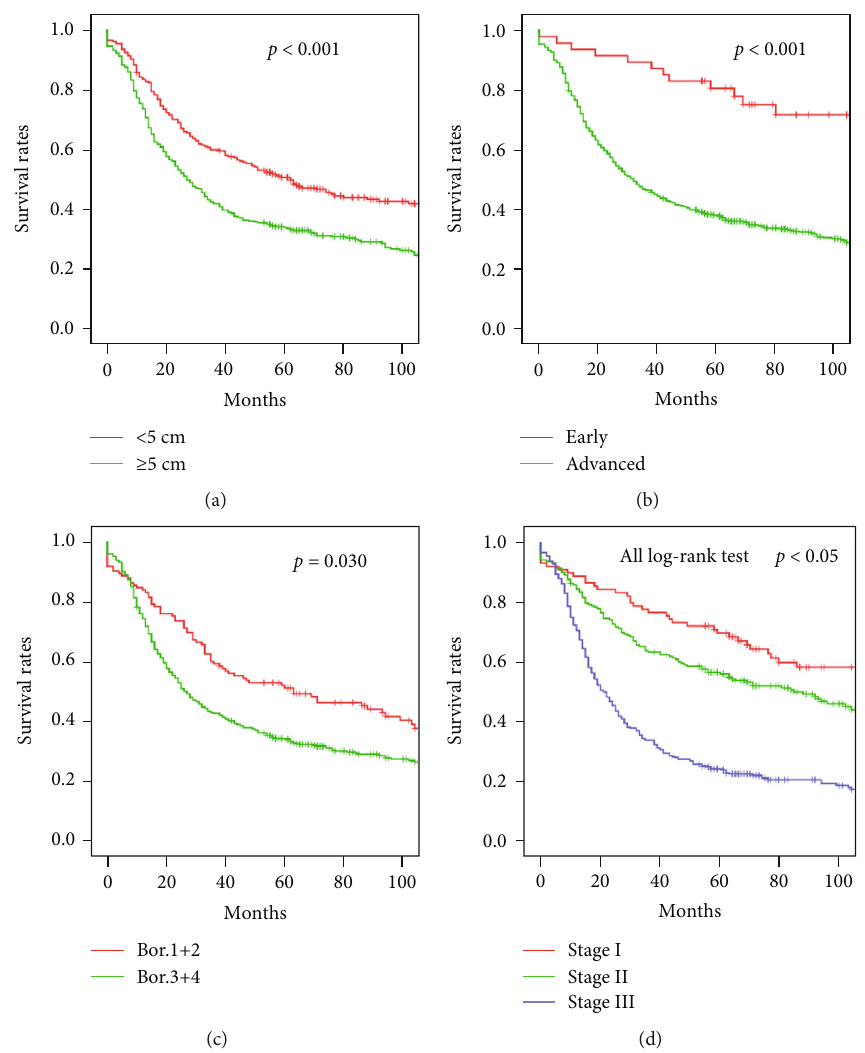
Figure 2: Survival of patients with upper gastric cancer: (a) tumor diameter, p < 0 : 001 ; (b) macroscopic type, p < 0 : 001 ; (c) Borrmann type, p = 0 : 030 ; (d) TNM stage, all log-rank test p < 0 : 05